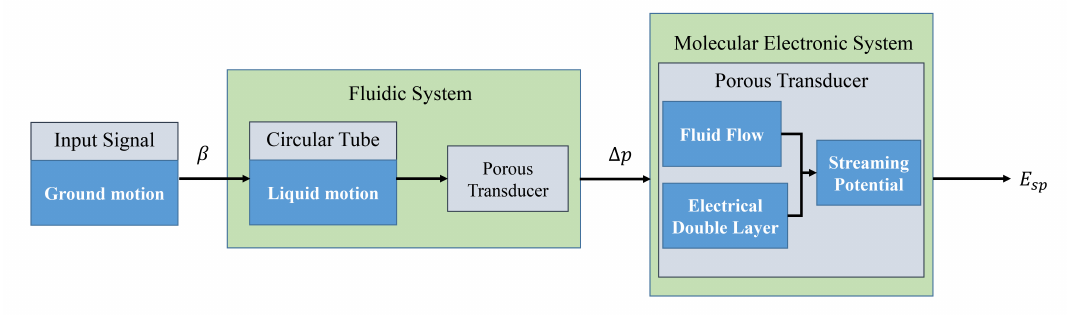
Figure 2. A block diagram of LCAA.